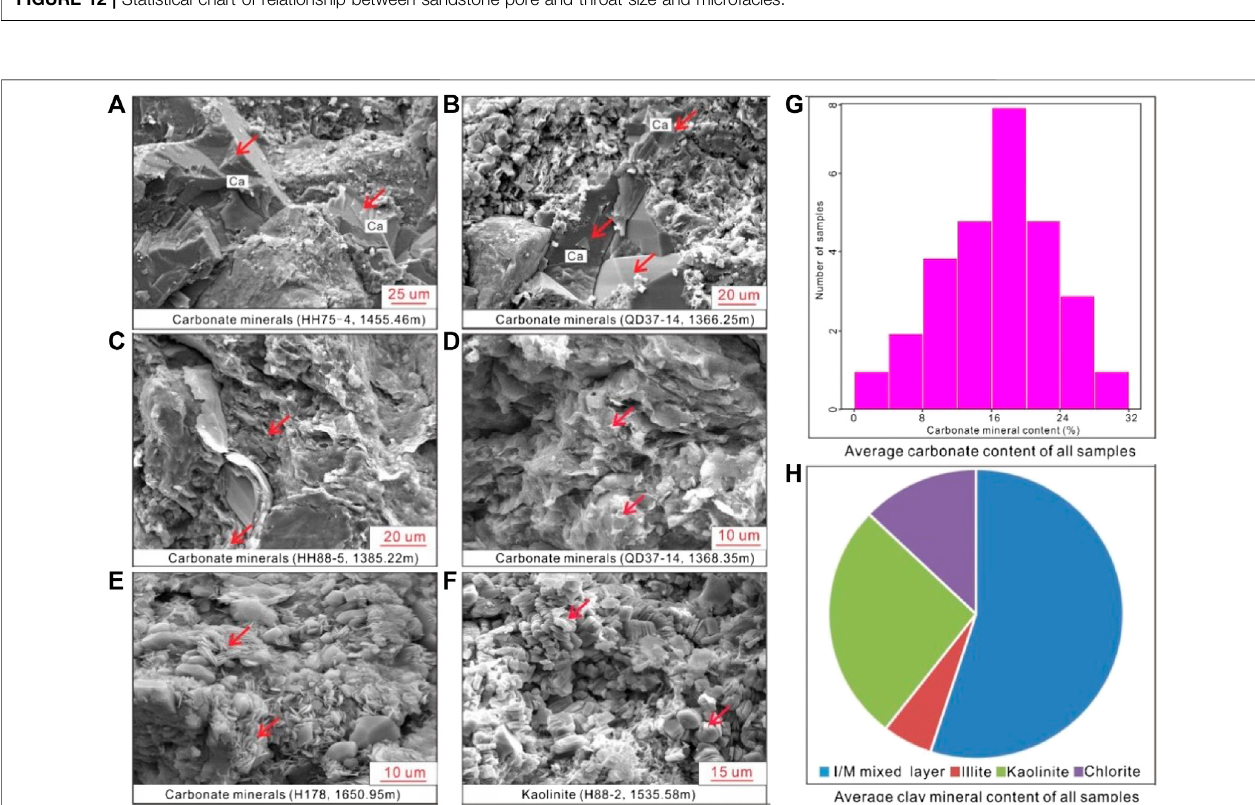
FIGURE 13 | Pore characteristics of sandstone: (A – F) pore structure and mineral characteristics observed by SEM; (G, H) content of different cementation minerals.